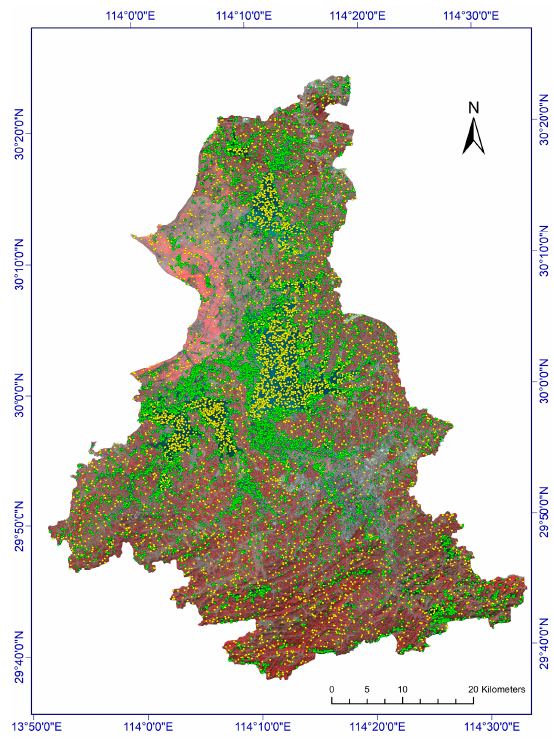
Figure 5. 2 m resolution GF-1 and GF-6 mosaicked image and the sample points used for the model assessment. The yellow points were used to assess di ff erent surface water mapping algorithms. The green points, which were mostly distributed within the mixed Sentinel-2 pixels, were used to assess di ff erent SPM algorithms. SPM, sub-pixel mapping. The false color image is composited with VNIR-red-green as RGB.